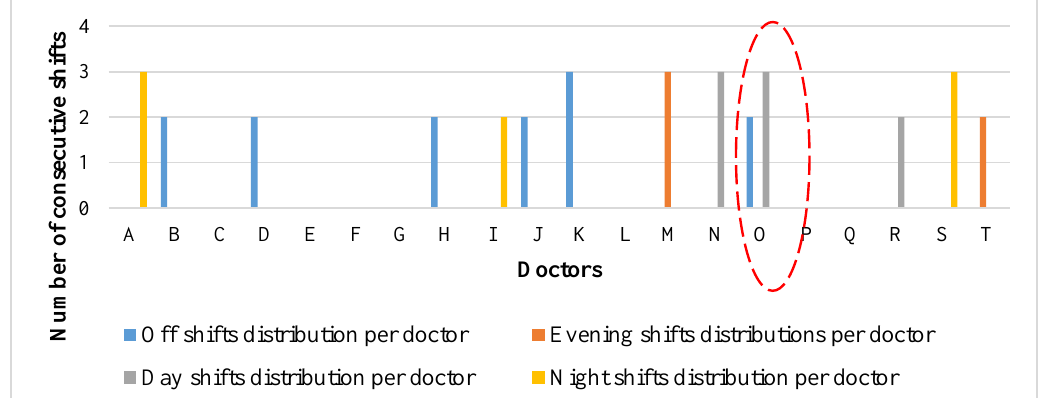
Figure 7. A Maximum Number of Successive Shifts. [Note: A to T are the doctors` names]